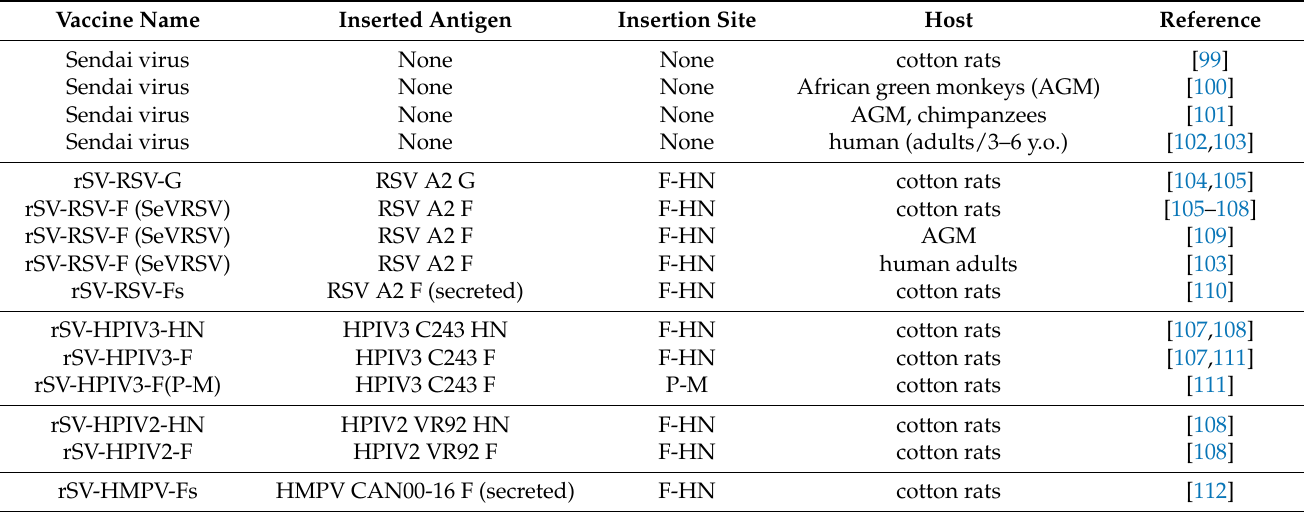
Table 3. Examples of research with SeV-based respiratory virus